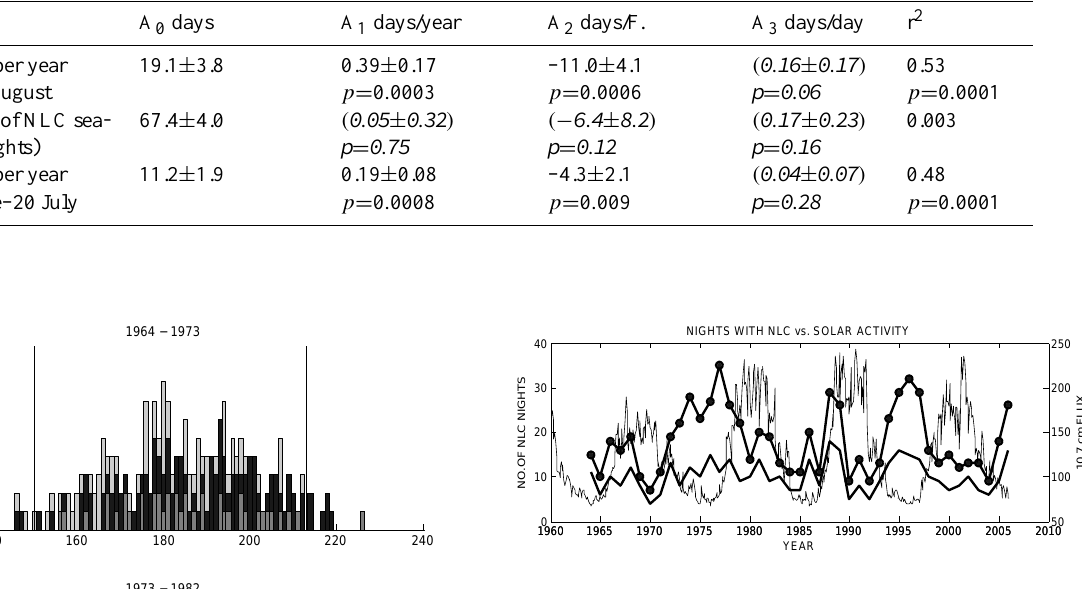
Fig. 4. Comparison of the number of nights with NLC for the whole season (solid dots and thick solid line) and (thick solid line) between 20 June and 20 July each year (excluding faint or very faint NLC) and the monthly average 10.7cm solar flux (thin line, right hand axis, units 10 − 22 Wm − 2 Hz − 1 ) . These are observed fluxes from Ottawa/Penticon from the National Geophysical Data Center web- site, www.ngdc.noaa.gov. Annual NLC counts are plotted at the same x-coordinate as the solar flux for the month of